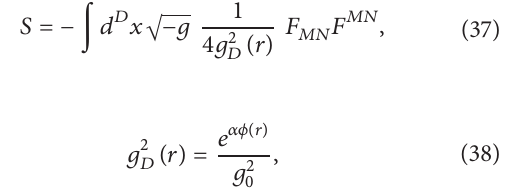
= 1 , 𝐷 = 4 , and 𝑉 = 1 . ℎ 2